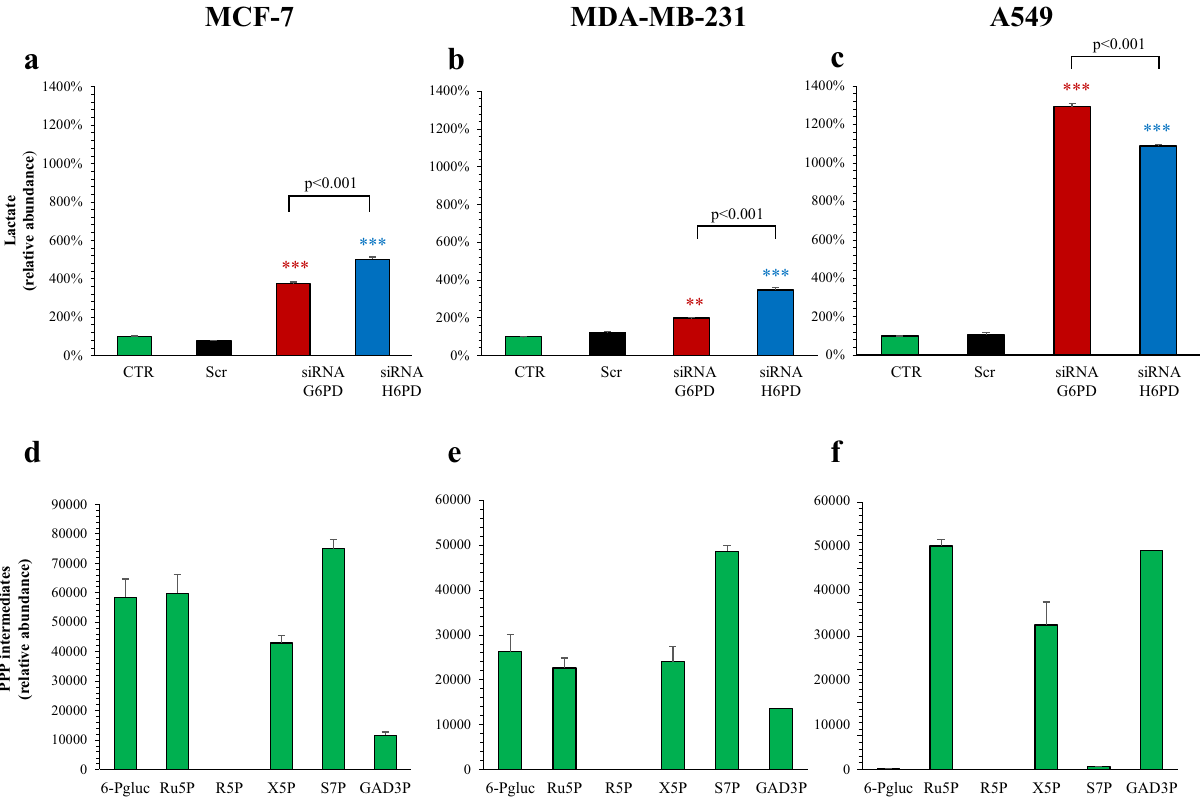
Figure 3. Lactate and PPP intermediates content. Relative lactate abundance in MCF-7 ( a ), MDA-MB-231 ( b ) and A549 ( c ) under control condition (CTR, green), scramble siRNA (Scr, black), siRNA G6PD (red) and siRNA H6PD (blue). In all cancer cell lines, silencing of either G6PD or H6PD significantly increase intracellular lactate level. Data are expressed as % vs CTR ± SD (n = 3). *p < 0.05 and ***p < 0.001 vs corresponding scramble. Panels ( c – e ) display the relative metabolite abundance of 6-phosphogluconic acid (6-PGluc), d-ribulose-5- phosphate (Ru5P), d-ribose-5-phosphate (R5P), xylulose 5-phosphate (X5P), sedoheptulose-7-phosphate (S7P) and d-glyceraldehyde 3-phosphate (GAD3P) in MCF-7 ( d ), MDA-MB-231 ( e ) and A549 ( f ) under control condition. Data are expressed as mean ± SD (n = 3). *p < 0.05 and ***p < 0.001 vs corresponding